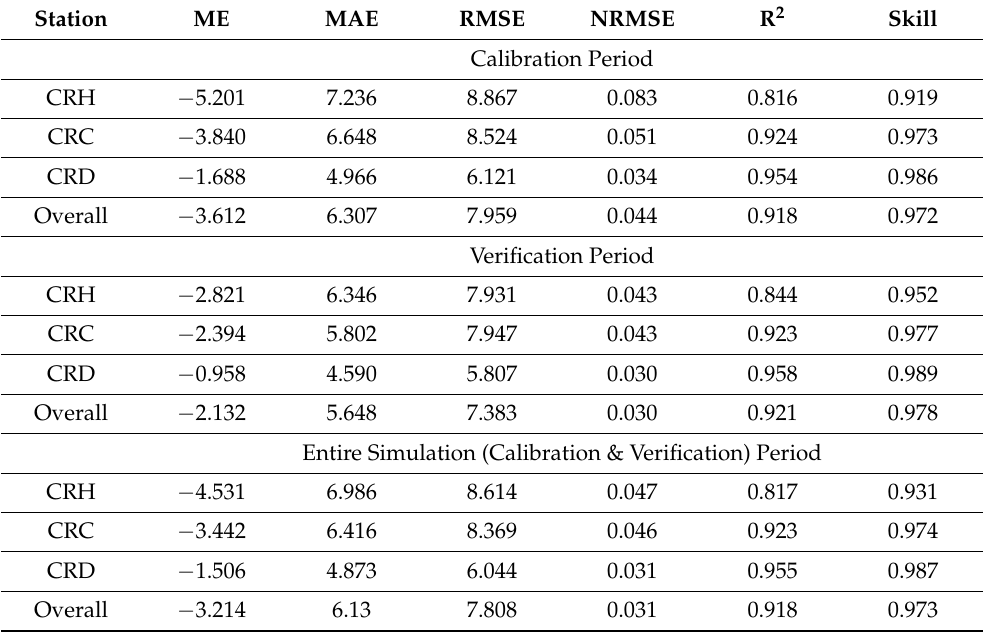
Table 2. MEs, MAEs, RMSEs, NRMSEs, R 2 values, and skills for simulated water levels (cm) in comparison with real-time field data measured at the CRH, CRC, and CRD stations during the calibration period, the verification period, and the entire simulation period.